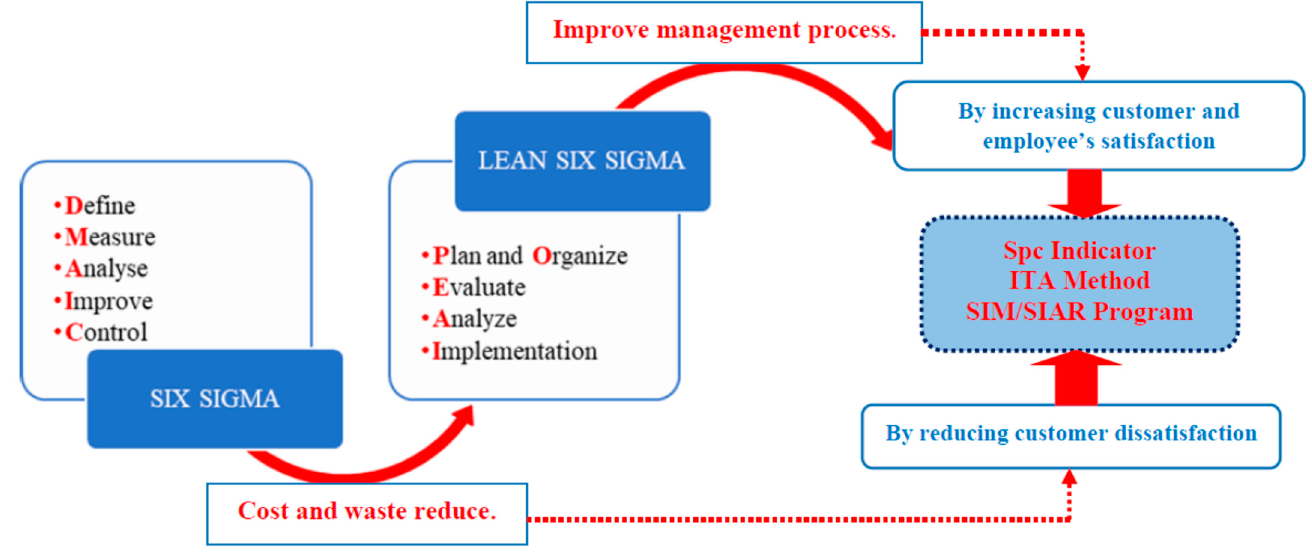
Figure 1. The conceptual framework of the research.